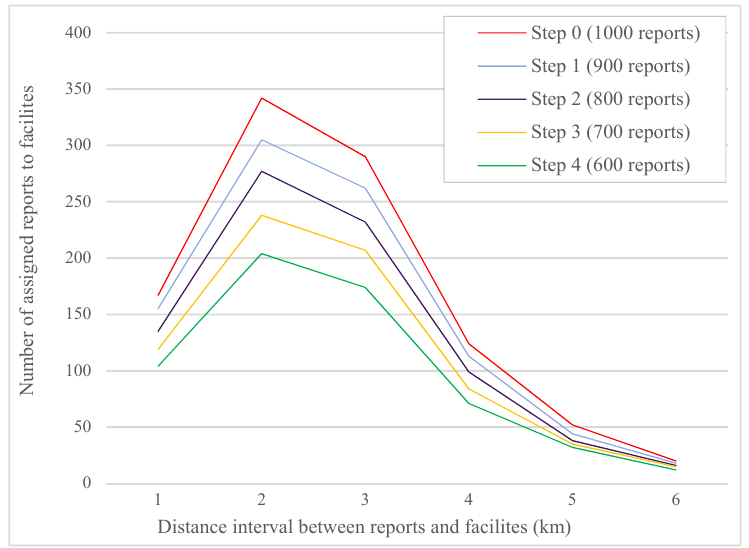
Figure 4. Number of assigned reports to facilities in distance intervals between facilities and reports.